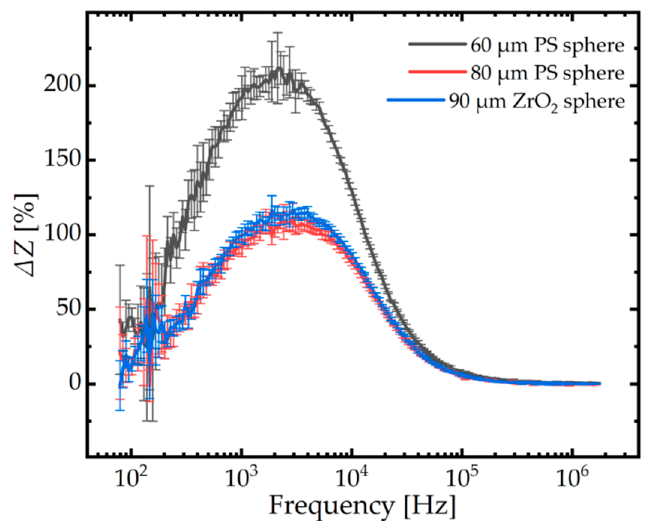
Figure 5. Normalized electric impedance change ∆ Z = Z m / Z 0 − 1 spectra from 80 Hz to 2 MHz of polystyrene and ZrO 2 spheres. Z m and Z 0 refer to the magnitude of the impedance of a measurement unit filled with a sphere and a measurement of an empty unit in 1 mM phosphate-buffered saline (PBS), respectively. Error bars of standard deviation are plotted.